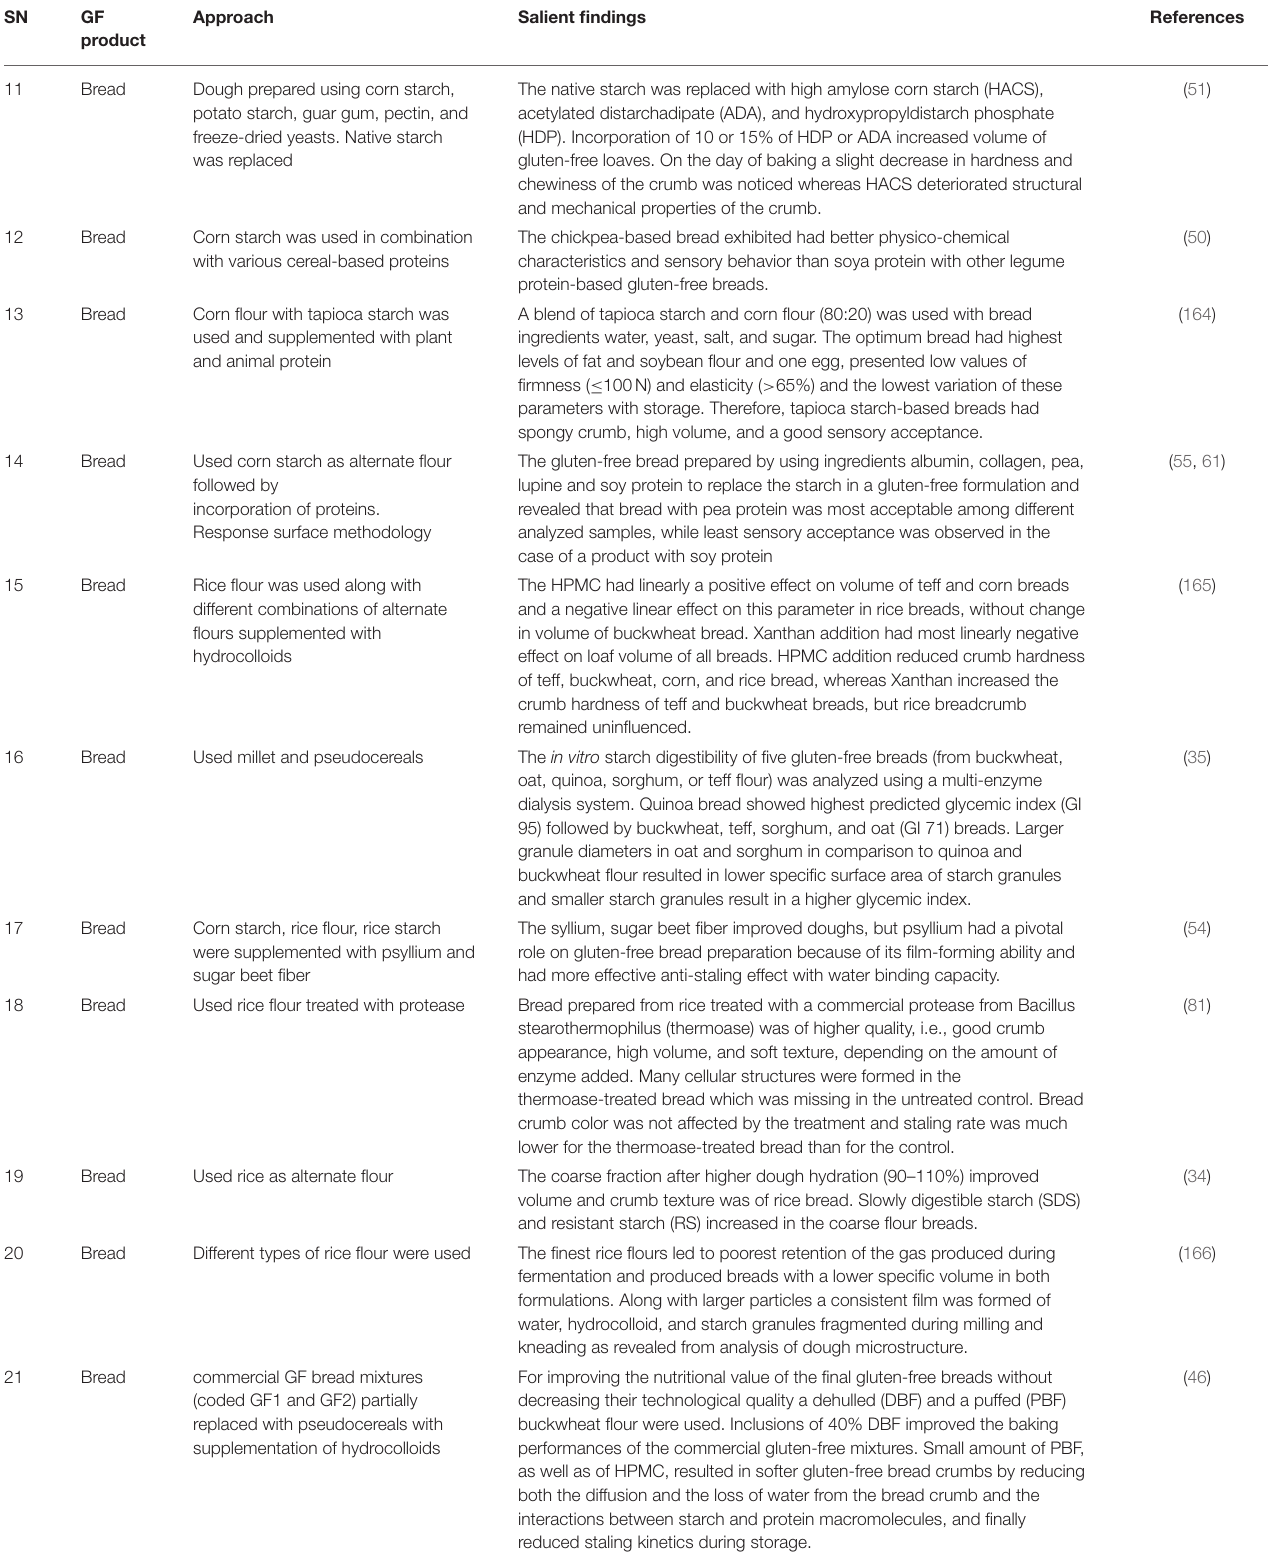
Bread Dough prepared using corn starch, potato starch, guar gum, pectin, and freeze-dried yeasts. Native starch was replaced